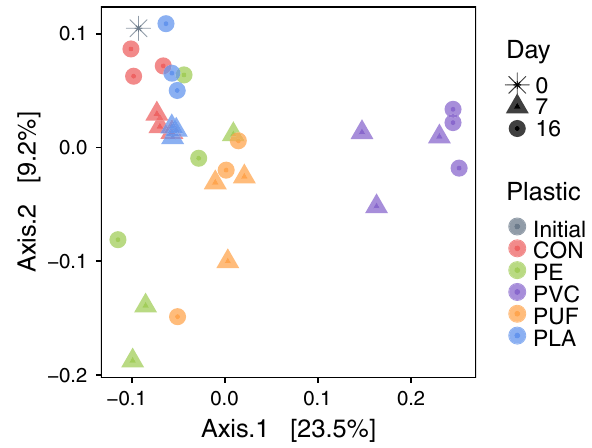
Fig. 2 Principal coordinate analysis of the sediment communities. Beta diversity was calculated using the Bray – Curtis dissimilarity index, and is plotted for all sample dates: initial (asterisk), 7 days (triangle), and 16 days (circle); and treatments: control (red; CON), PE (green), PVC (purple), PUF (orange), and PLA (blue). Signi fi cant effects of the plastic treatment ( p = 0.001), day ( p = 0.001) and interaction ( p = 0.023) were tested by